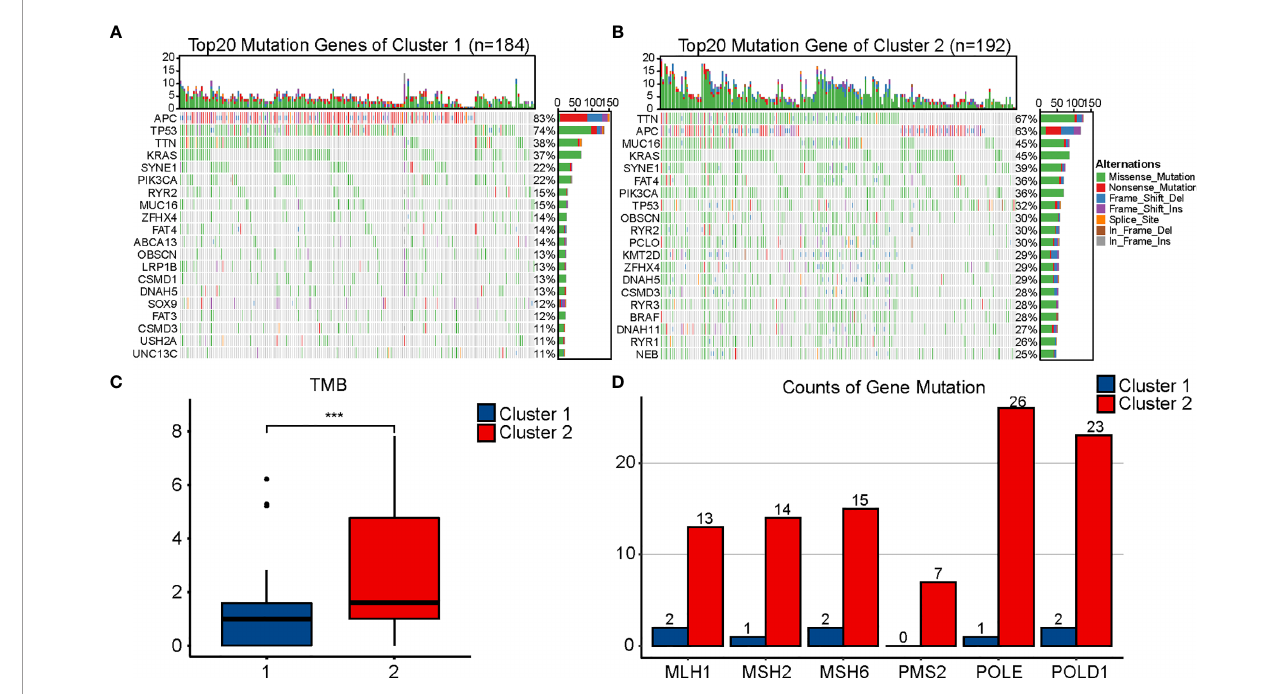
FIGURE 4 | Comparison of mutational landscapes between two clusters. Mutational landscape of Cluster 1 (A) and Cluster 2 (B) . (C) Comparison of tumor mutation burden (TMB) between two clusters. (D) Comparison of gene mutation related to mismatch repair and POLE proofreading domain between two clusters. The P values are labeled using asterisks (***P <